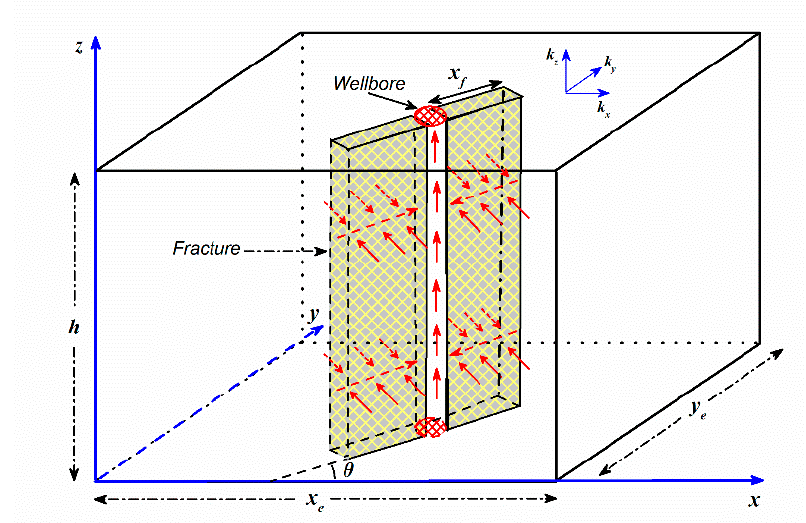
Figure 1. Schematic representation of a vertical well penetrated by a finite-conductivity fracture with an azimuth angle in an anisotropic rectangular reservoir.